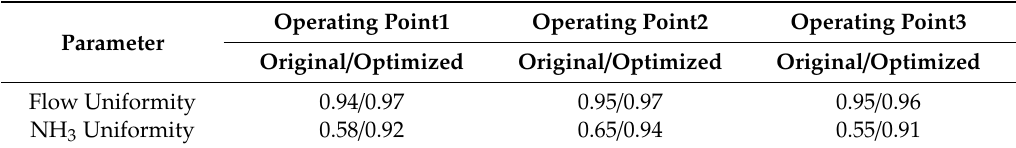
Table 3. Simulation Results of Different Operating Points.